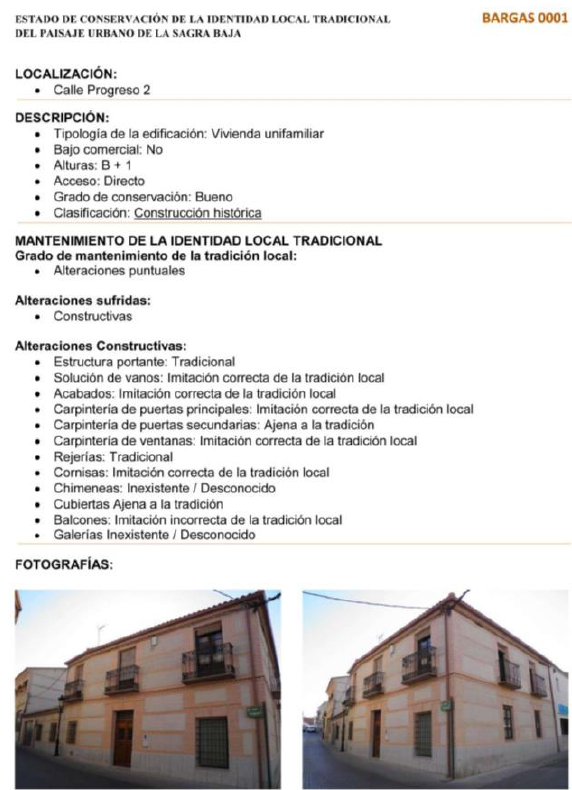
Figure 3. Sample of the data sheets used for historic